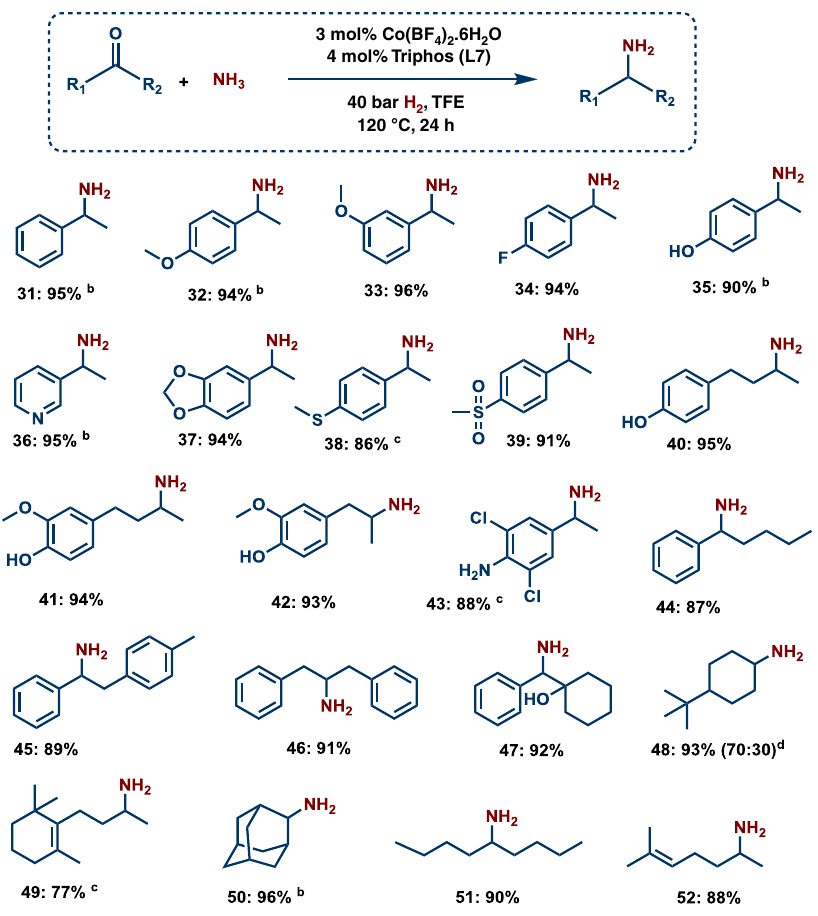
Fig. 2 Synthesis of primary amines from ketones using cobalt-triphos catalyst. Reaction conditions: a 0.5 mmol ketone, 3 mol% Co(BF 4 ) 2 ⋅ 6H 2 O, 4 mol% triphos ( L7 ), 5 – 7 bar NH 3 , 40 bar H 2 , 2 mL degassed TFE, 120 °C, 24 h. b GC yields using n-hexadecane as standard. c Same as ‘ a ’ with 50 bar H 2 . d Diastereomeric ratio. Isolated as free amines and converted to hydrochloride salts. Corresponding hydrochloride salts were subjected to NMR analysis.